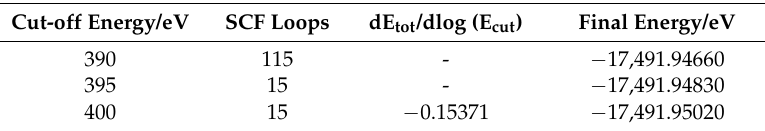
Table 2. Convergence test results of energy cut-off in DFT calculation (CASTEP module of Materials Studio 6.0 software package, PBE density function, Hubbard + U